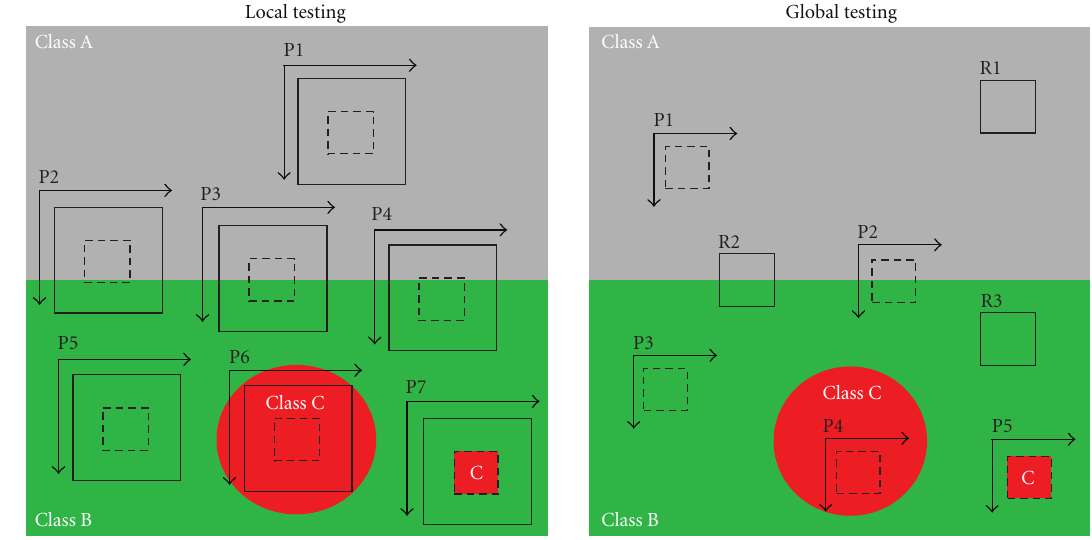
Figure 2: Most common window-based testing scenarios in anomaly detection problems, assuming for simplification that the scene background consists of two distinct material types (Class A and Class B) and a third material (Class C) also distinct from Class A and Class B depicts a anomalous material relative to the